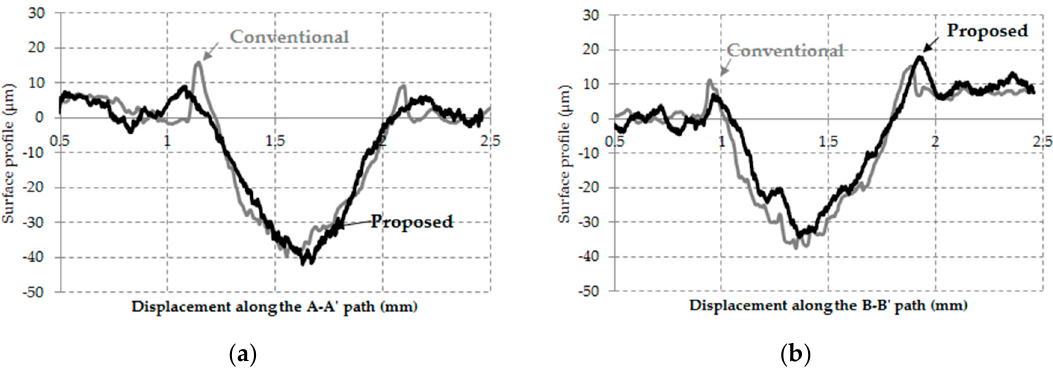
Figure 6. Direct comparison of surface profiles between the conventional stylus method and the proposed method: ( a ) A–A’ direction; ( b ) B–B’ direction.